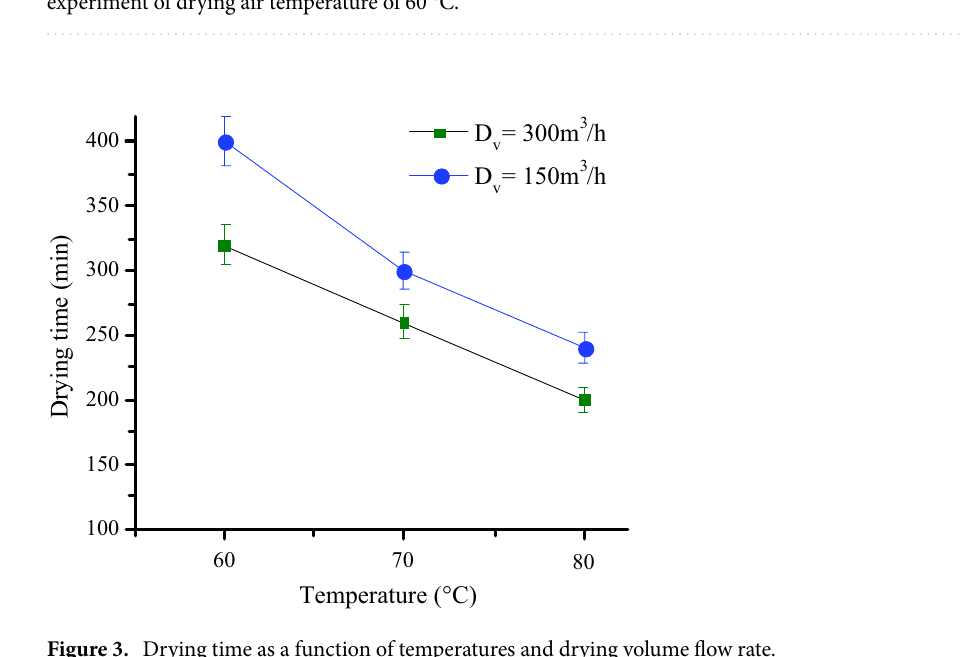
Figure 2. Air relative humidity, temperature ( A ) and solar radiation ( B ) on the dryer collector during the experiment of drying air temperature of 60 °C.